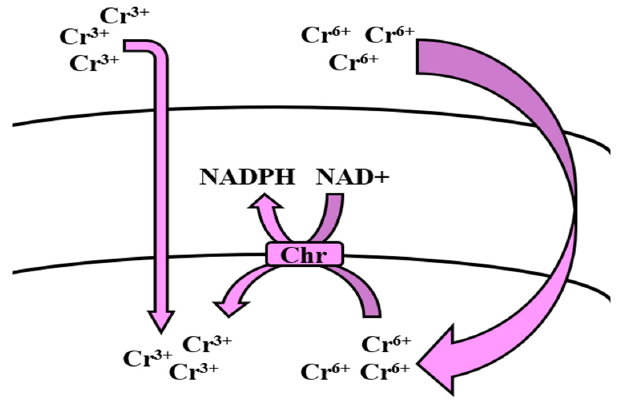
Figure 7. Uptake mechanism of Bacillus spp. for cadmium and its